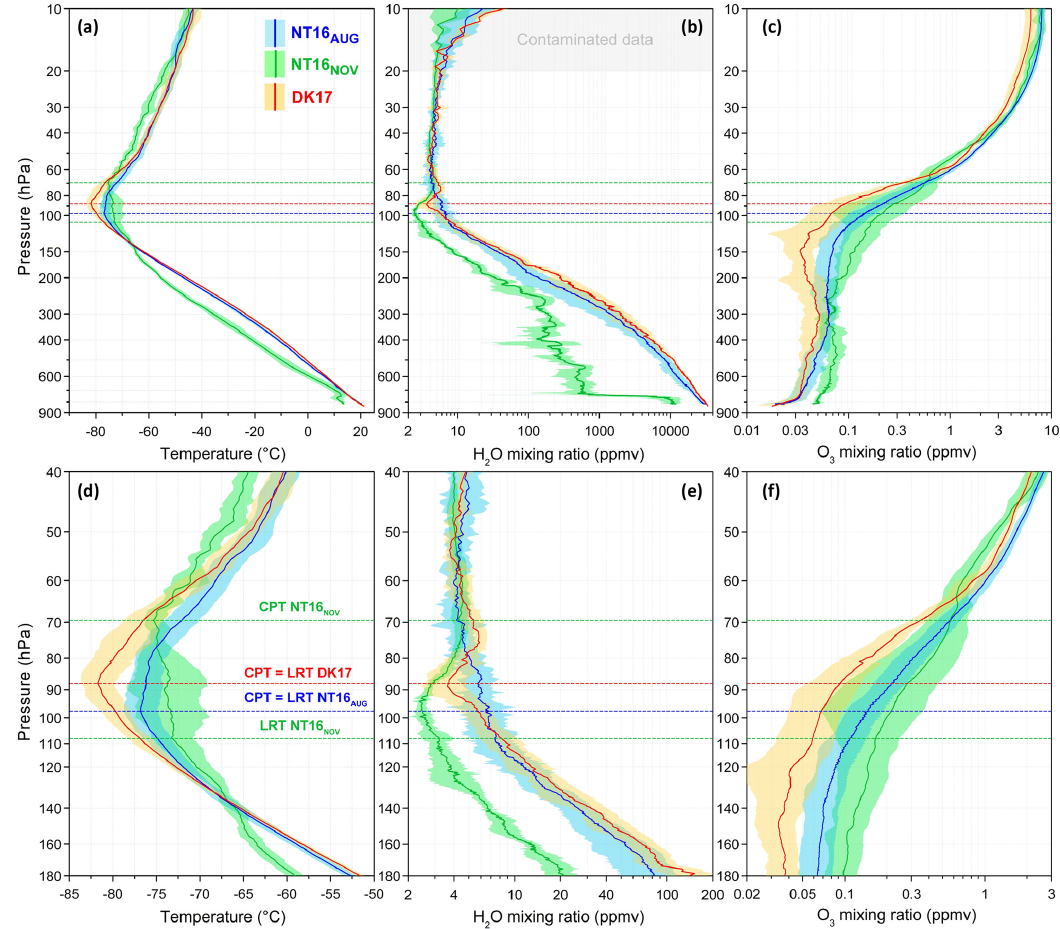
Figure 1. Mean profiles (solid lines) and standard deviations (colored shading) of all measurements of temperature from RS41 (a, d) , the H 2 O mixing ratio from CFH (b, e) and the O 3 mixing ratio from ECC (c, f) as a function of pressure, for NT16 AUG (blue), NT16 NOV (green) and DK17 (red). Dashed lines indicate the pressure levels of the average cold-point tropopause (CPT) and lapse-rate tropopause (LRT) for the different datasets. Measured profiles from the surface to 10hPa (a–c) . A zoomed in profile of the tropopause region (40–180hPa) (d–f) . The grey shaded area in (b) indicates the region of contaminated CFH data (see Sect.